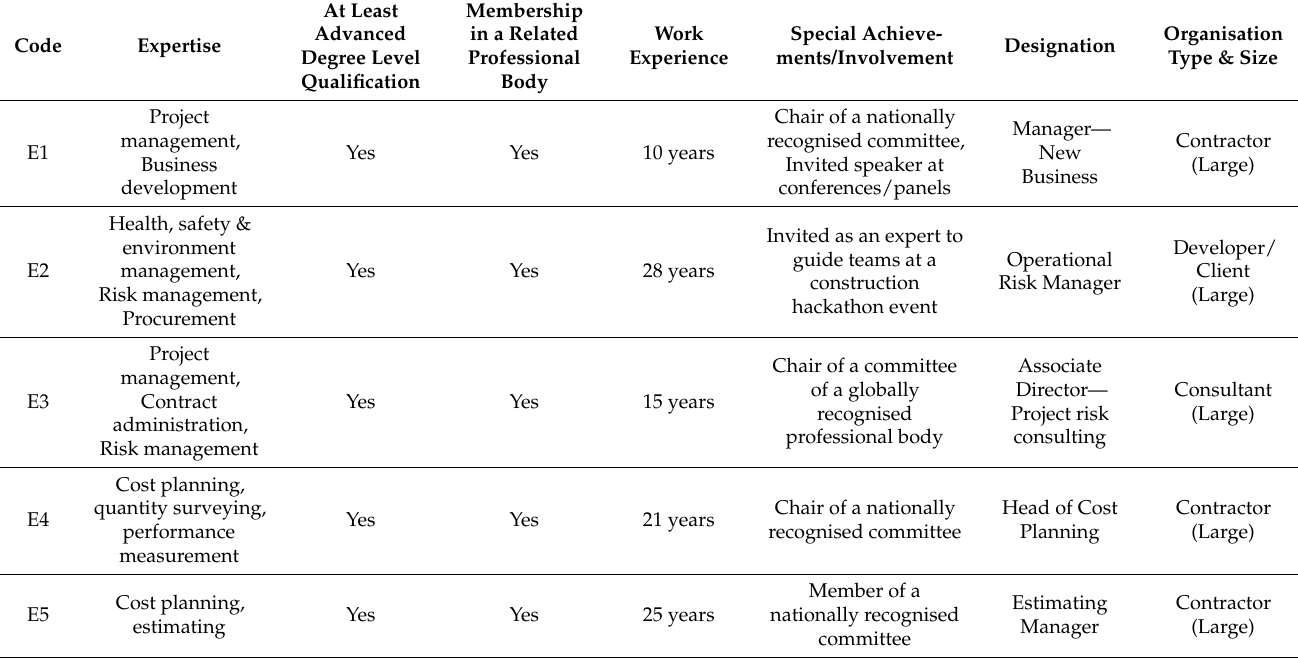
Table 2. Profiles of the expert forum